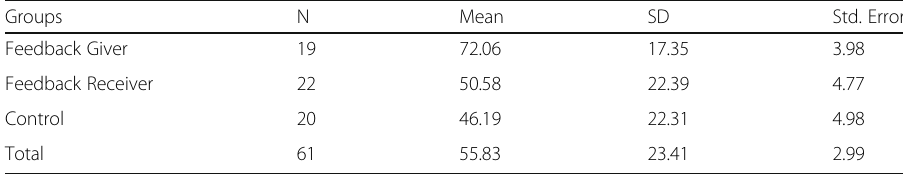
Table 3 Descriptive statistics for the translation task